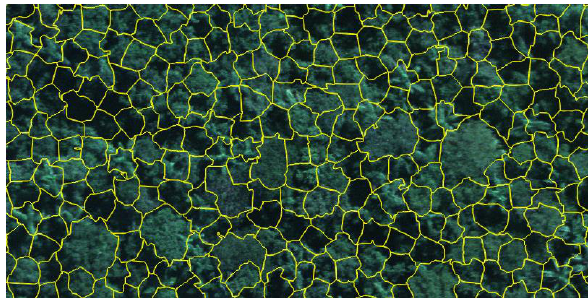
Figure 3. Final superpixels representing the individual tree crowns